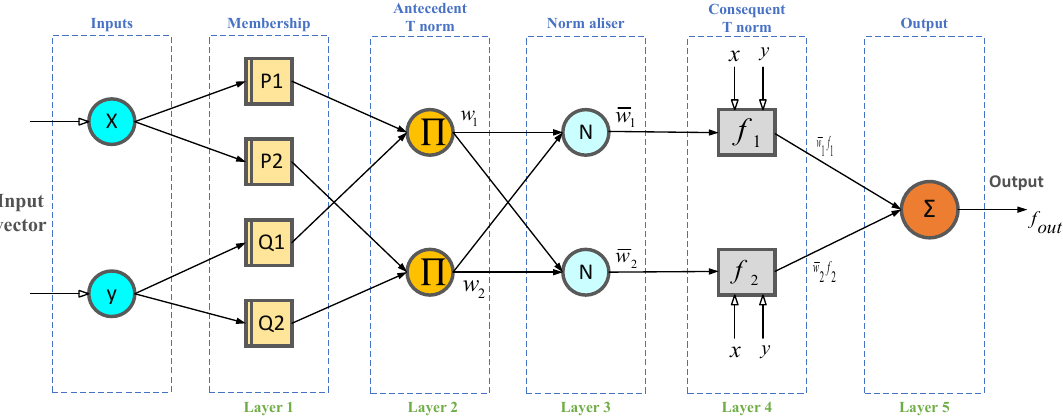
Figure 2. The structure of the adaptive neuro-fuzzy inference system (ANFIS) method consisting of two rules, two model inputs, one model output.